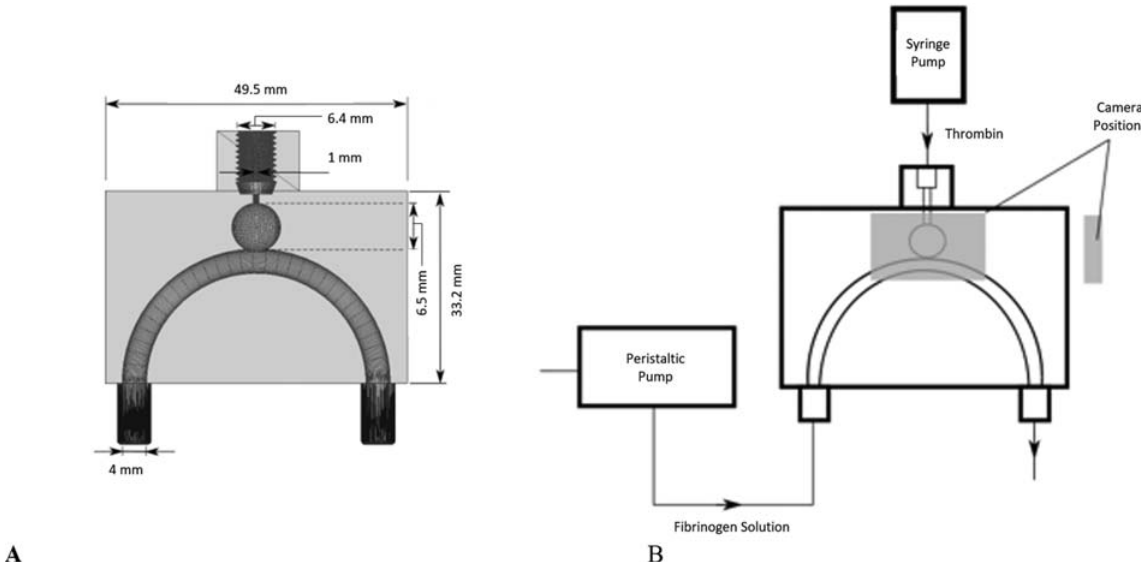
Fig. 1 (A) Flow setup illustrating the positioning of the different components relative to the fl ow phantom. (B) Design of the fl ow phantom which includes screw top to prevent